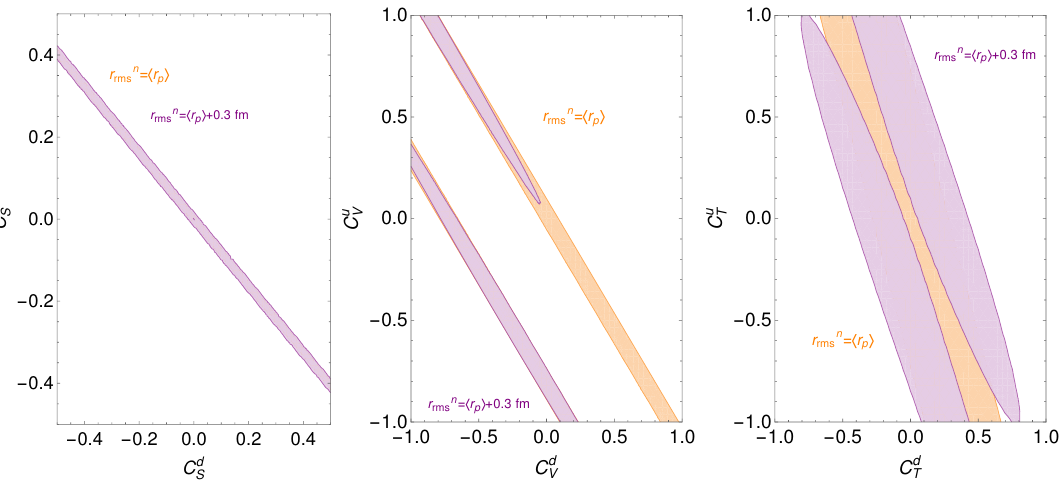
Figure 7 . 90% C.L. allowed regions in the NGI parameter space for scalar interactions assum- ing D q = 0 ( left ), for vector NGI assuming D q P The orange bands are obtained by (cid:12)xing r n j max = 5 : 09 r n = r n rms rms